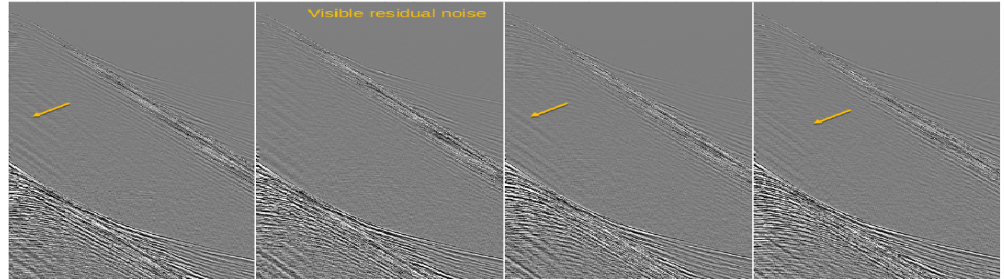
Figure 8. Filtered seismic image of the 60 sail